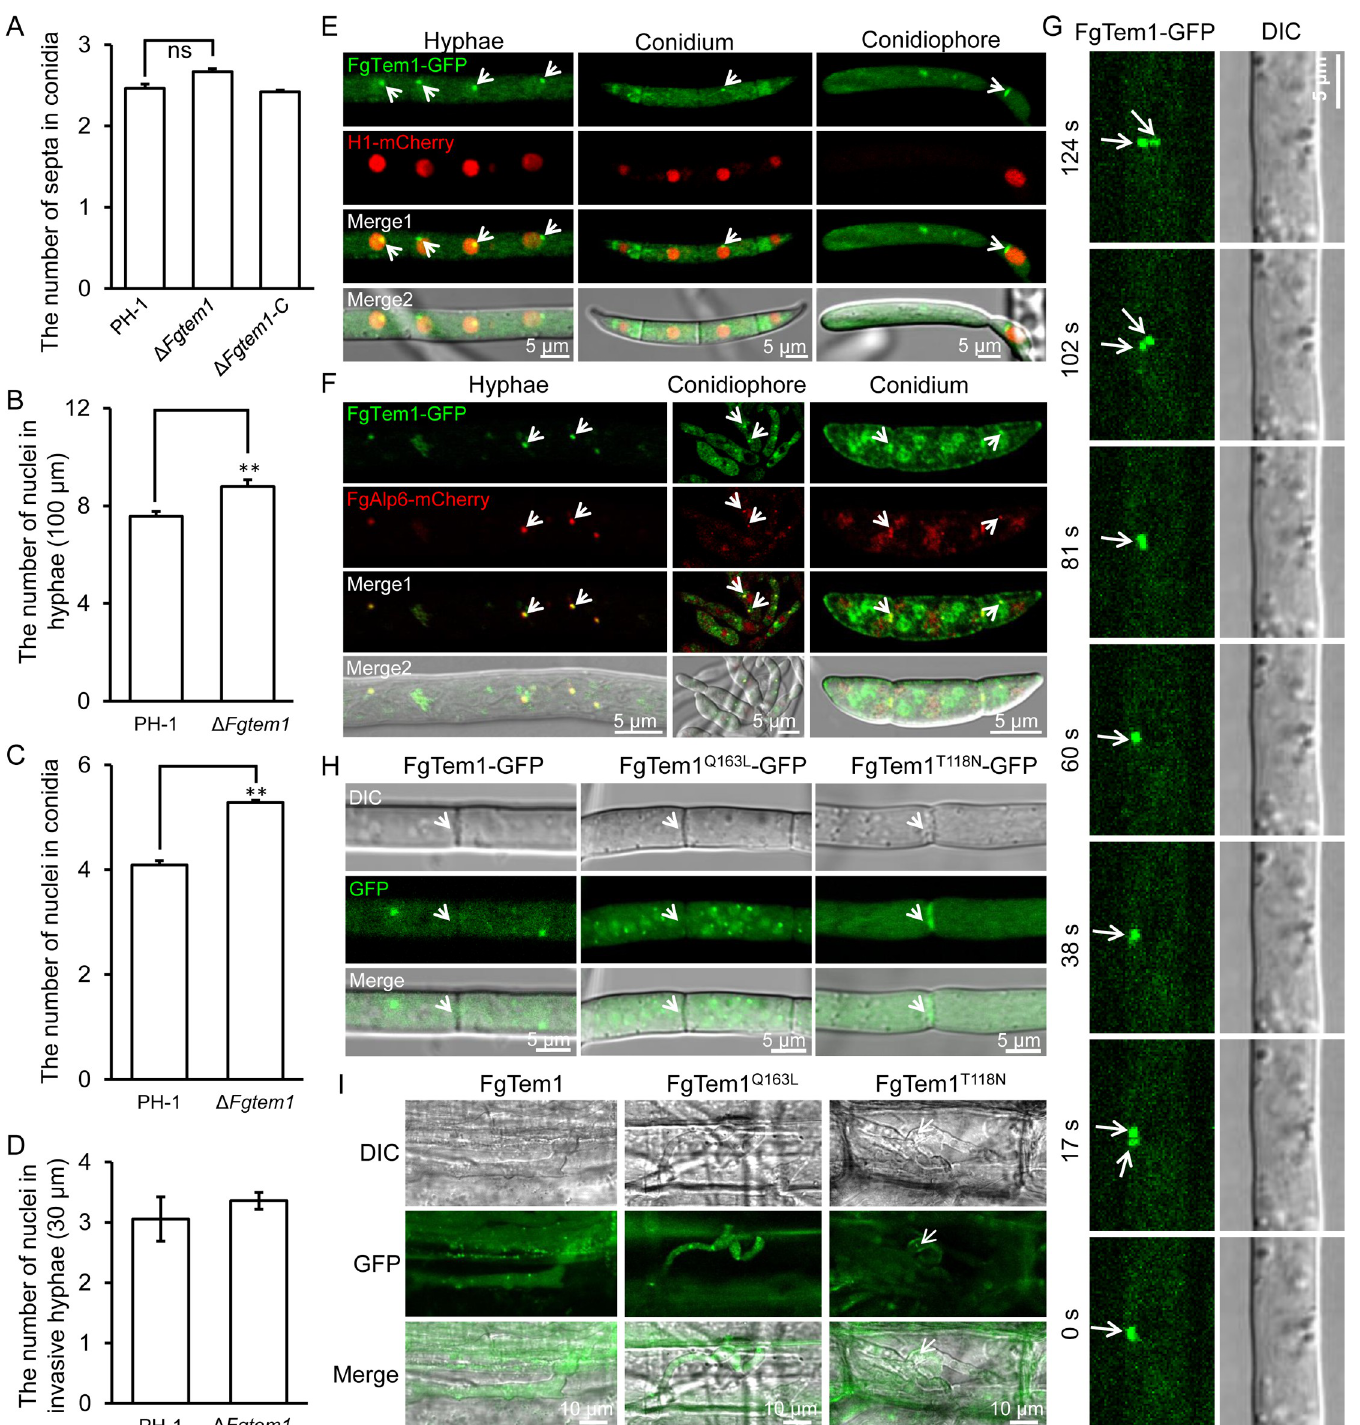
Fig 2. FgTem1 plays an important role in nuclear division and localizes to spindle pole bodies. (A) The number of septa in the conidia of the indicated strains. Two- tailed Student t -test was used for paired comparison of the number of septa in the conidia of Δ Fgtem1 and PH-1. (P = 0.06, ns, no significant difference). (B-C) The number of nuclei in the hyphae (100 μ m) and conidia of the indicated strains. ( �� P < 0.01). (D) The number of nuclei in the invasive hyphae (30 μ m) of PH-1 and Δ Fgtem1 strains. (E) FgTem1-GFP localizes to the nuclear periphery in the hyphae, conidiophore and conidium. H1-mCherry is expressed to mark the nuclei. White arrowheads show the FgTem1-GFP localization. (F) FgTem1-GFP co-localizes with FgAlp6-mCherry in F. graminearum hyphae, conidiophores and conidia. FgAlp6-mCherry is a spindle pole body (SPB) marker. White arrowheads show the co-localization. (G) Time-lapse images of FgTem1-GFP, times are indicated in